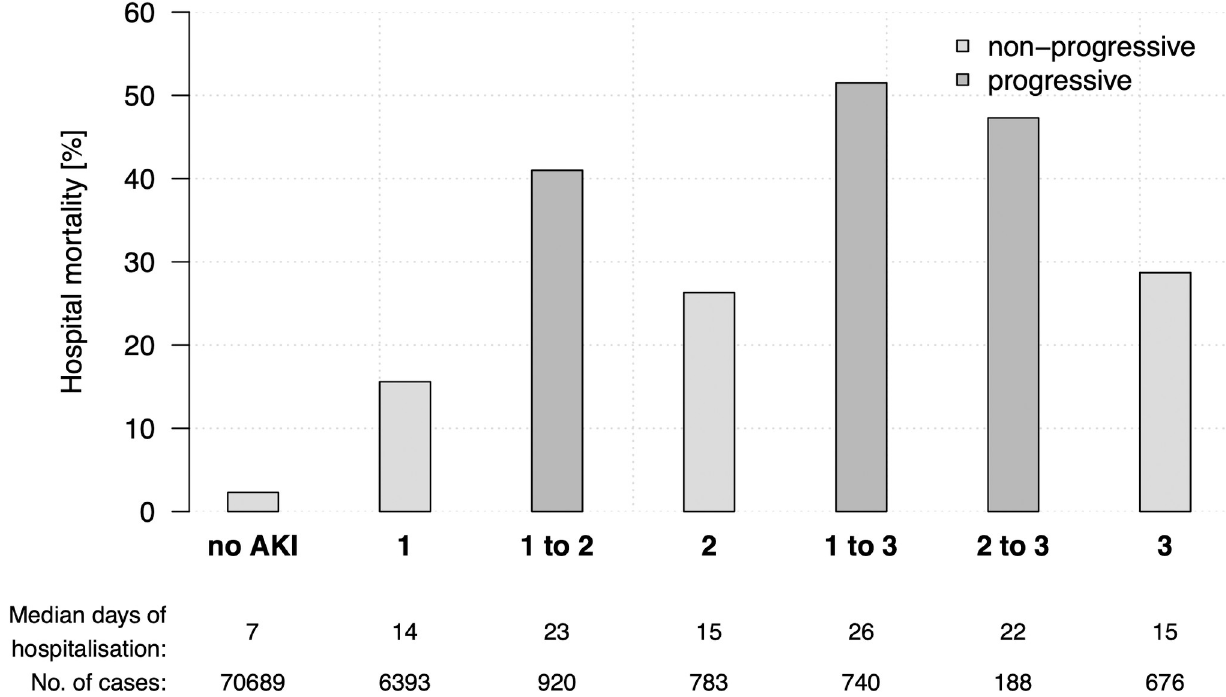
Fig 2. Mortality of patients with progressive and non-progressive AKI, and those without AKI. Hospital mortality in % for progressive and non- progressive AKI. Patients were divided into six groups according to the first and maximum detected AKI stage, which is equal for non-progressive AKI (AKIN1, AKIN2, AKIN3) and given as AKIN X to Y (X = first and Y = max AKI stage) for progressive AKI.